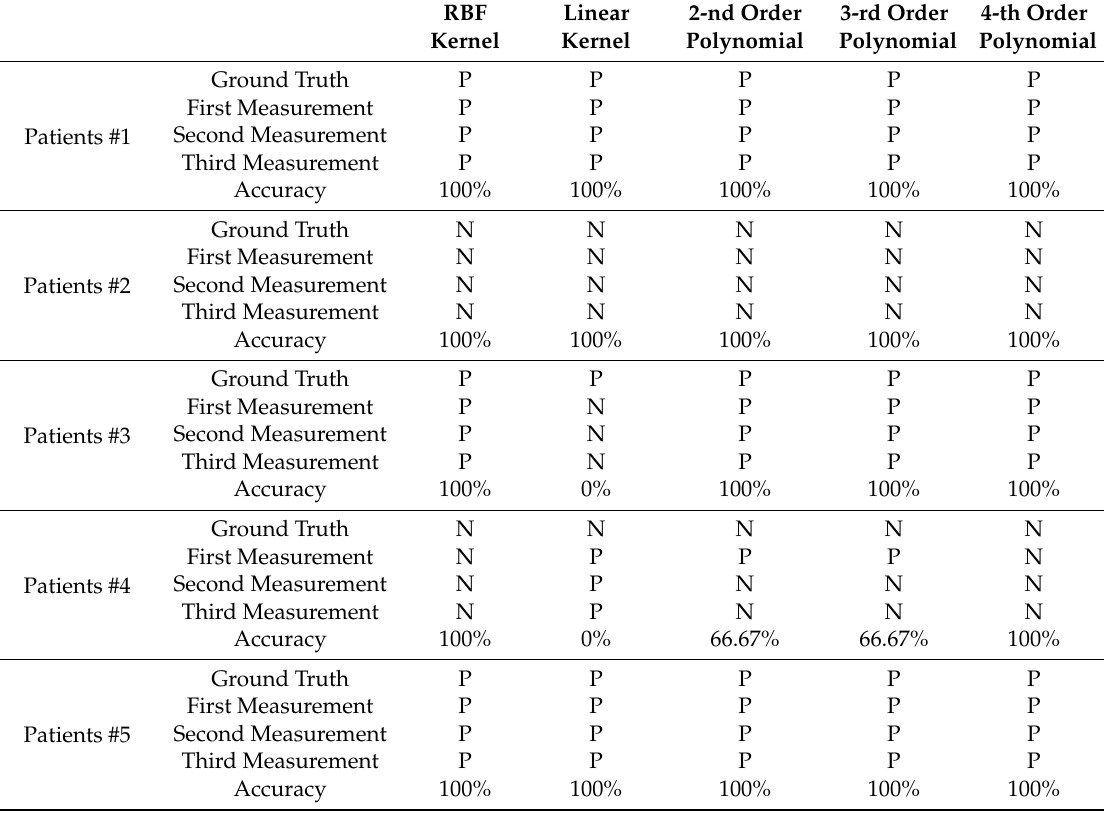
Table 3. Reproducibility test of the proposed PPG